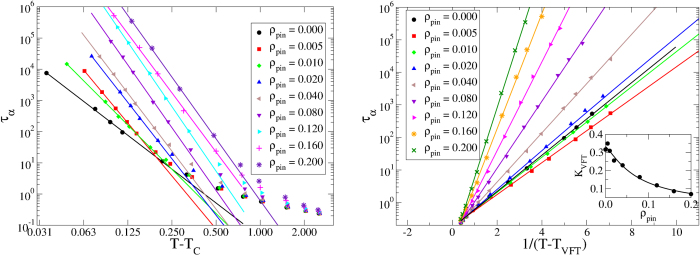
MCT and VFT Fits for 3dR10 Model.Left Panel: Power-law fits to obtain TC as a function of ρpin for the 3dR10 model with γ = 4. Right Panel: VFT fits to obtain TVFT as a function of ρpin for the 3dR10 model. Inset: Kinetic fragility KVFT as a function of ρpin. The line corresponds to an exponential fit to the data.